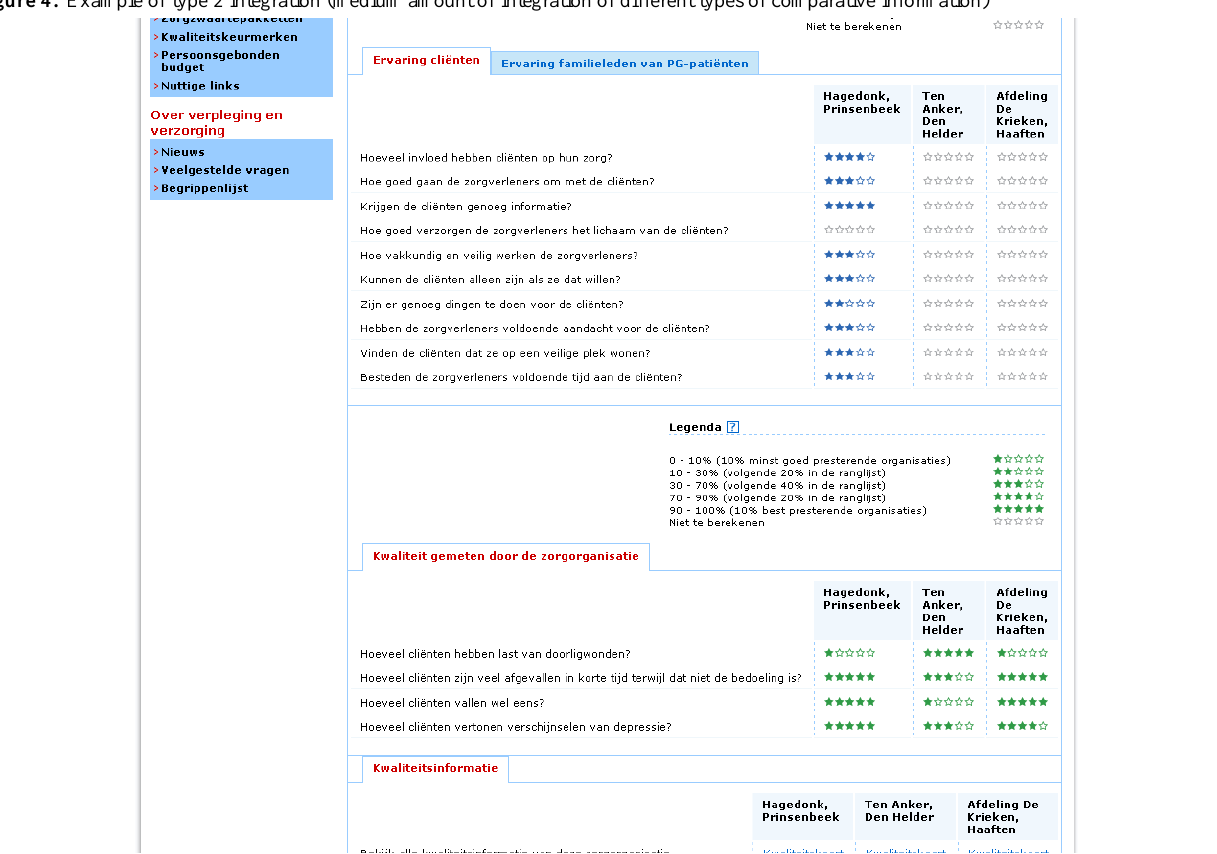
Figure 4. Example of type 2 integration (medium amount of integration of different types of comparative information)